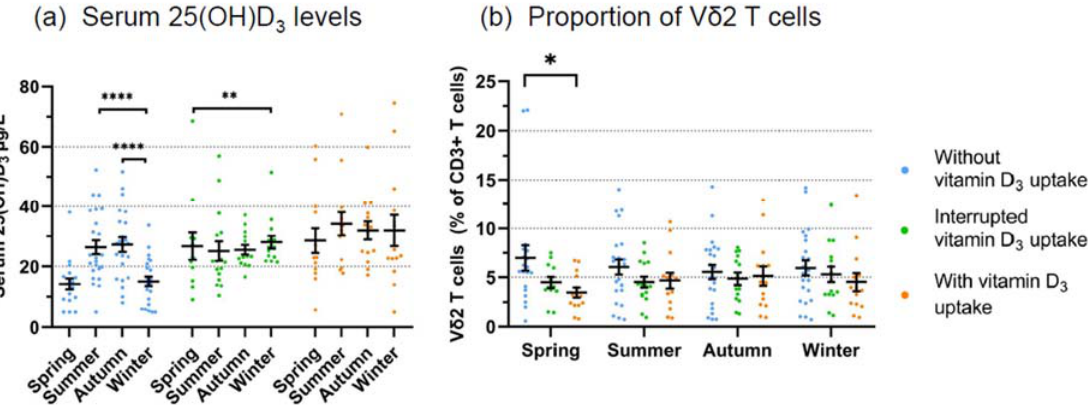
Figure 3. Seasonal fluctuation of serum 25(OH)D 3 levels and proportion of V δ 2 T cells according to oral vitamin D 3 supplementation. ( a ) Serum levels of 25(OH)D 3 in donors without vitamin D 3 supplementation (left panel, blue symbols), in donors with interrupted vitamin D 3 uptake (middle panel, green symbols), and in donors with regular vitamin D 3 uptake (right panel, orange symbols). Statistical comparison was made by Wilcoxon matched pairs signed-rank test, by testing each season against winter. ( b ) The proportion of V δ 2 T cells among CD3 T cells according to the season in the same individuals. Bars represent mean values ± SEM. Statistical comparison was made by Kruskal–Wallis test and Dunn’s multiple comparison test. * p = 0.0276; ** p < 0.01, and **** p <